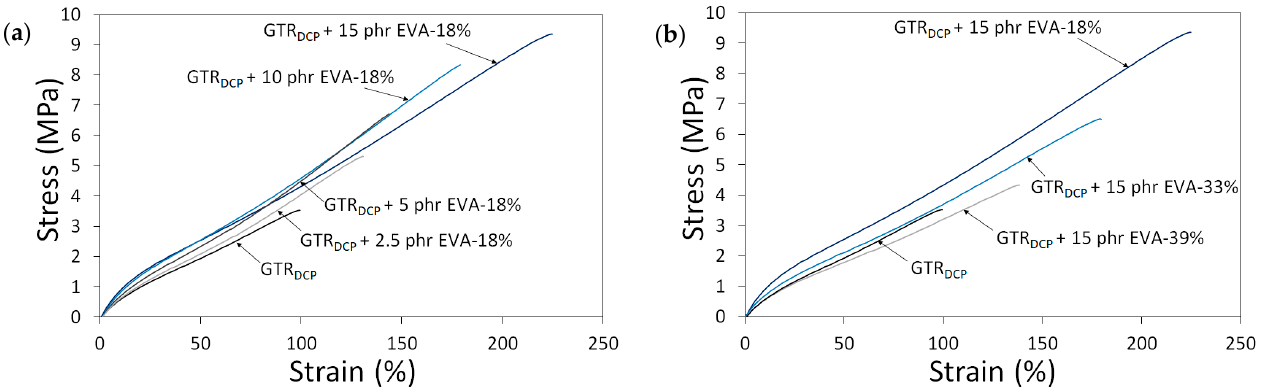
Figure 3. Stress–strain curves as a function of: EVA content (0–15 phr) ( a ) and EVA grade (VA content: 18–39%) ( b ). The results of the physico-mechanical properties of modified GTR, including tensile strength (MPa), elongation at break (%), hardness (Shore A), density (g/cm 3 ), swelling degree (%), cross-link density (mol/cm 3 10 − 4 ), and sol and gel fraction content (%) as a function of EVA content and EVA grade, are summarized in the graphs presented in Figure 4. The black line in the presented graphs represents the reference sample without an EVA copolymer modifier (GTR DCP sample).